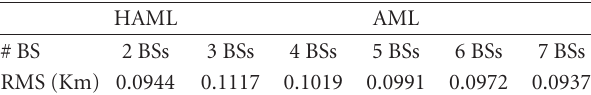
Table 1: Performance comparison of 2-BS HAML and AML with various number of